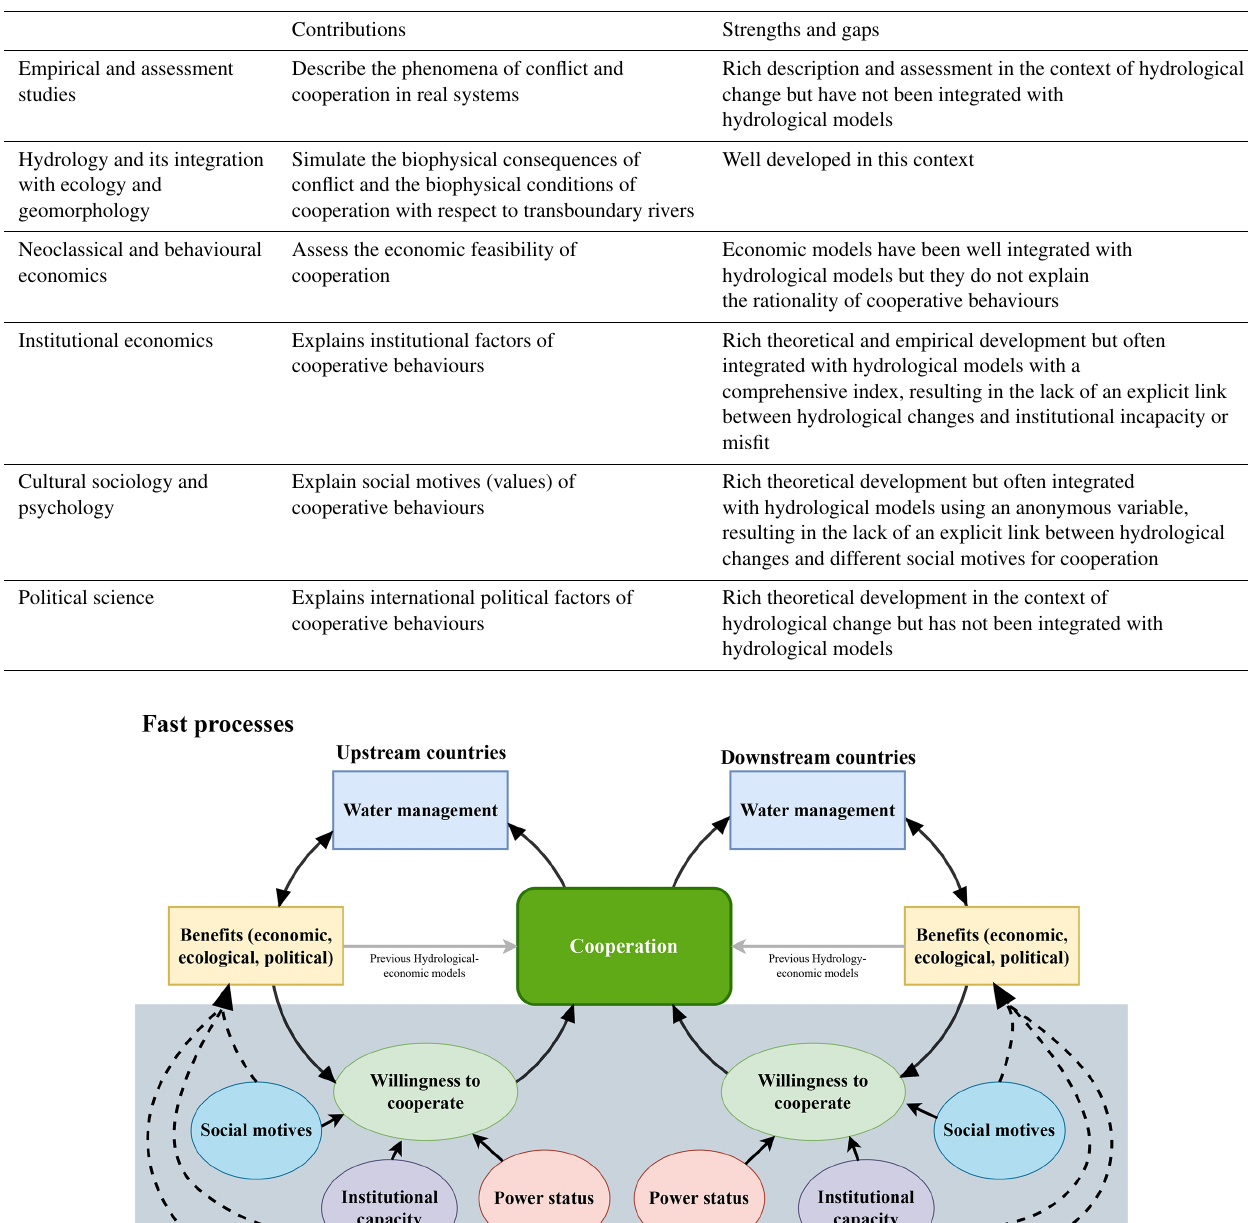
Table 1. Current disciplinary and empirical understandings of conflict and cooperation with respect to transboundary rivers.